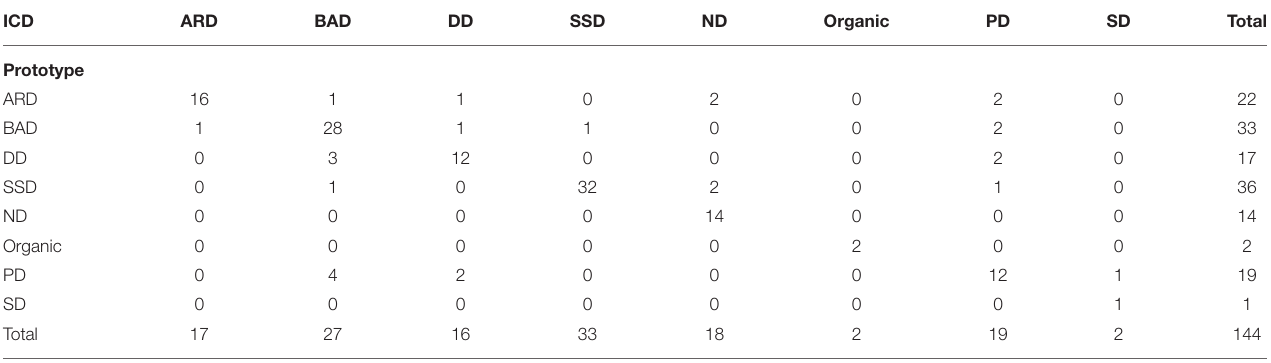
ARD, anxiety-related disorders; BAD, bipolar affect disorder; DD, depressive disorder; SSD, schizophrenia spectrum disorder; ND, neurodevelopmental disorder; organic, brain damage or degenerative-related disorders; PD, personality disorders; SD, substance-related disorders.